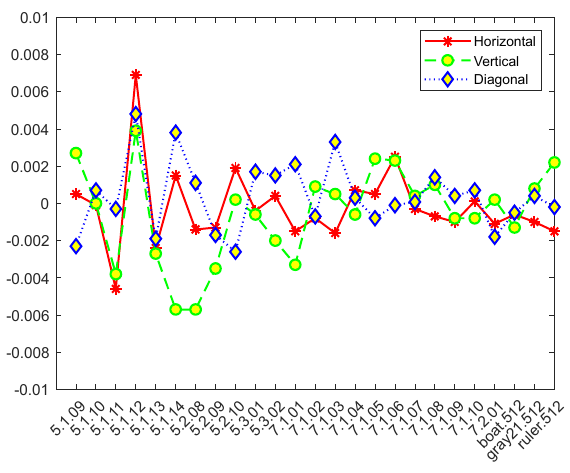
Figure 13. Correlation of different ciphertext images.